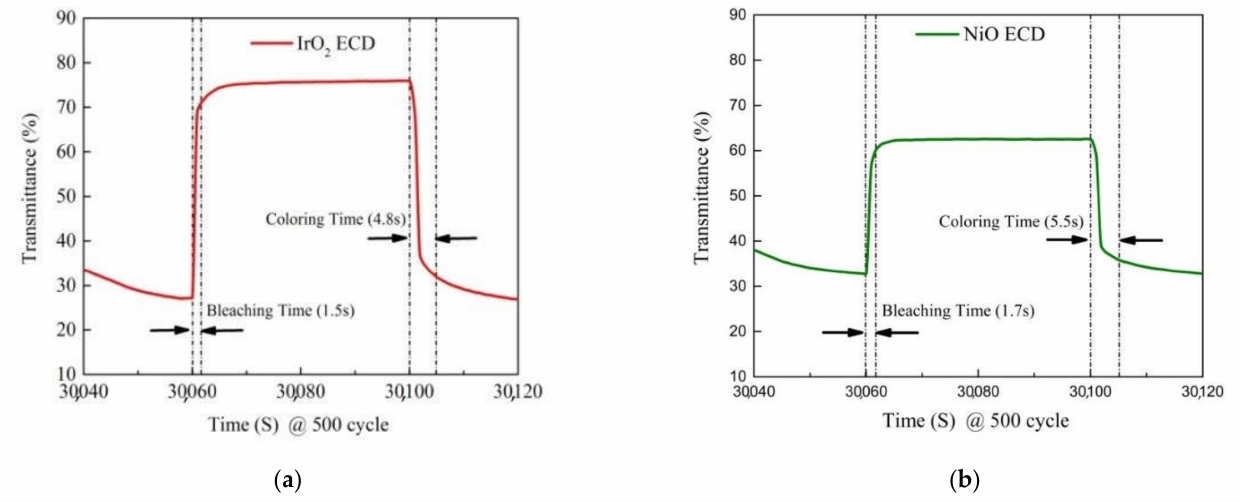
Figure 9. ( a ) IrO 2 ECD and ( b ) NiO ECD: Switch response time for one single bleaching and coloring states @ 500 cycle (30040 → 30120 s). Table